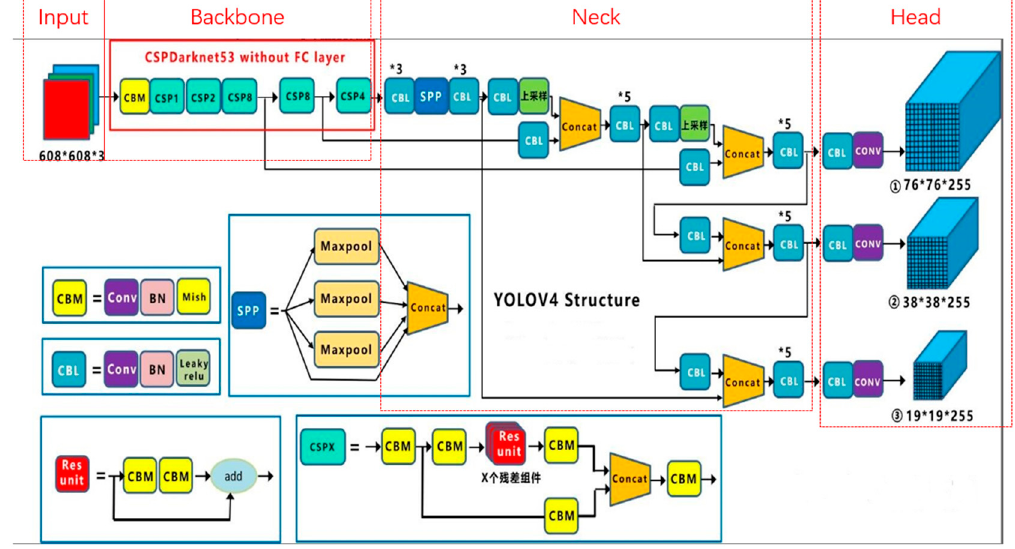
Figure 5. Architecture diagram of traditional YOLOv4.